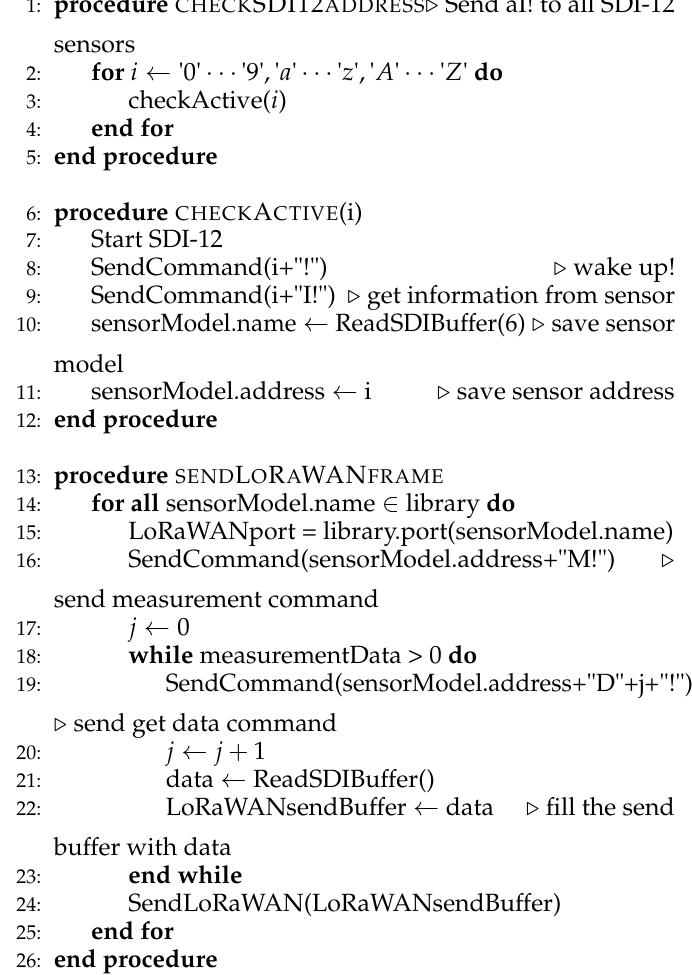
Figure 5. Part of the firmware algorithm. The SDI-12 related high-level pseudo-code.